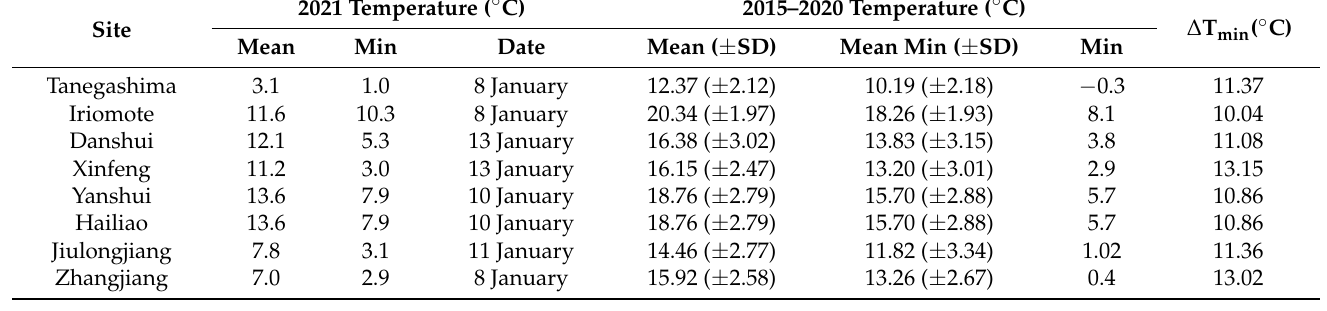
Table 2. Mean and minimum recorded temperature for the 2021 winter (1 November 2020–1 March 2021), as well as corresponding winter mean and mean minimum temperature from the past five years (2015 to 2020) along with their standard deviations (SD). Dates for 2021 minimum temperatures are given. ∆ T min is computed as the difference between the mean temperature for 2015–2020 baseline and the 2021 minimum temperature. A moving 7-day average was applied to the 5-year baseline daily temperatures to compute the mean temperature and the mean minimum temperature.